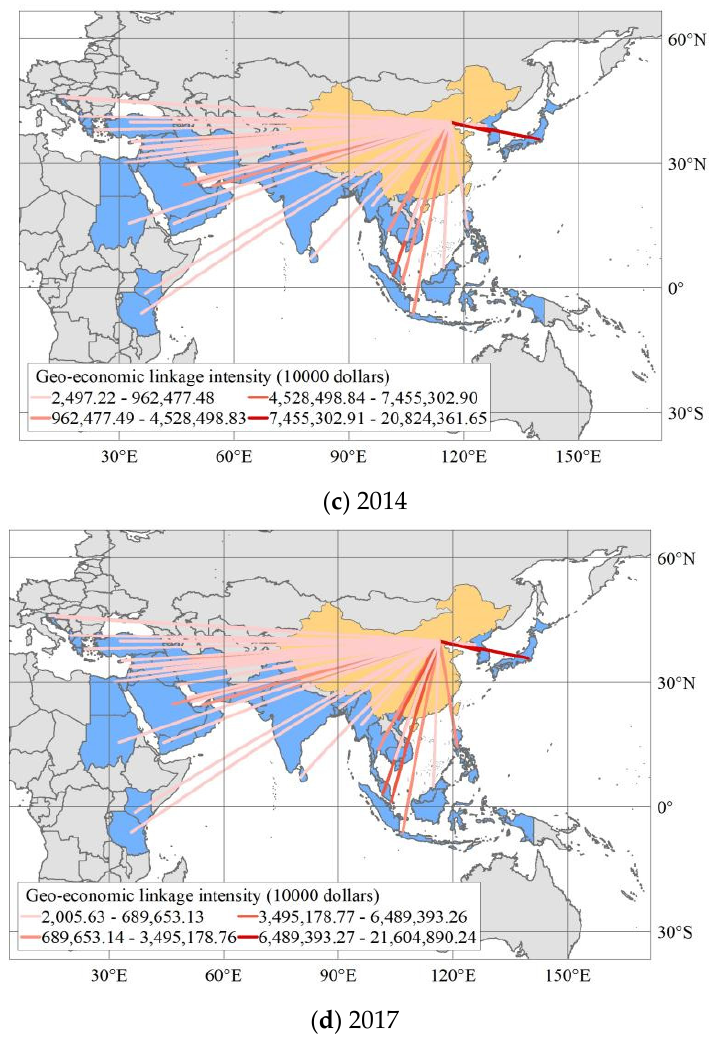
Figure 3. The spatial distribution of geo-economic linkage intensity between China and MSRCs.